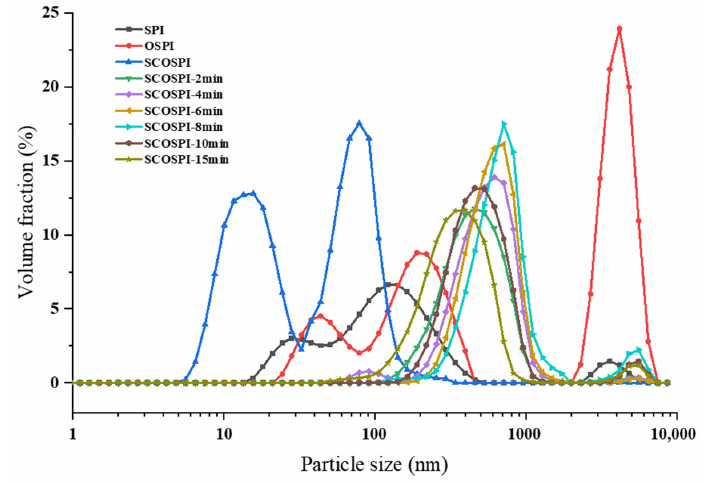
Figure 1. Particle size distribution (PSD) of natural, oxidized soybean protein, and the cavitation jet treated on soluble soybean protein oxidized accumulates at several times (2, 4, 6, 8, 10, and 15 min).